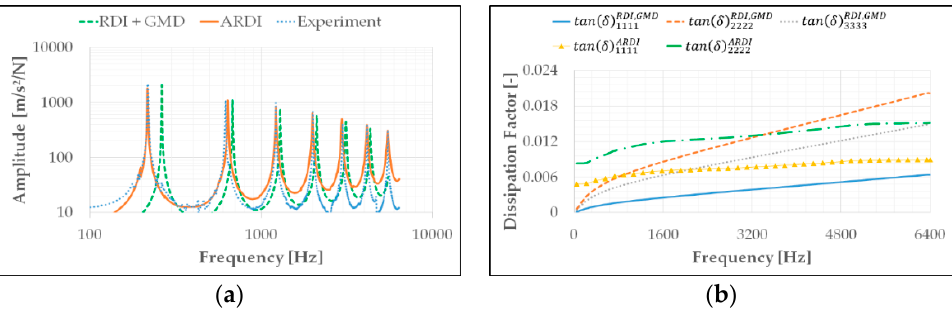
Figure 16. ( a ) Frequency response function (FRF) of the Reconsidered ‐ Double ‐ Inclusion (RDI) model with global modal damping (GMD), the ARDI model and the experiment of PA66 ‐ GF30 of the IF orientation at 23 °C and 0% rh and ( b ) dissipation factors of the RDI and ARDI model.